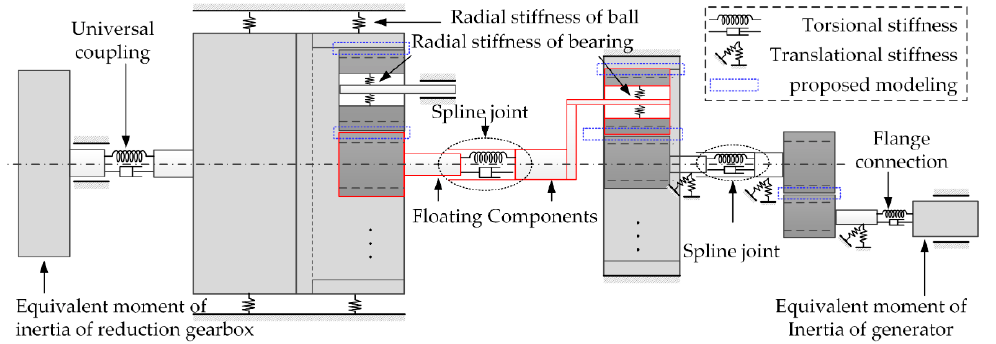
Figure 6. The LTC dynamic model of the entire test rig.